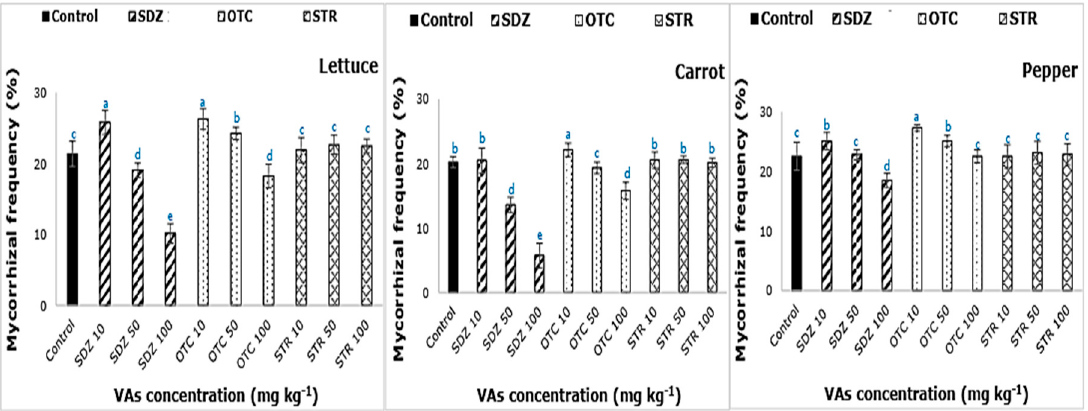
10 of 14 Figure 3. Glutathione-s-transferase (GST) activity of lettuce, carrot and pepper grown in soil treated with VAs. Error bars represent standard error. Concentration values followed by different letters are significantly different ( p < 0.05) according to Duncan’s multiple range test. SDZ = Sulfadimethoxine; OTC = Oxytetracycline; STR = Streptomycin. 3.4. Secondary Experiments In Figure 4, the mycorrhizal frequency (F%) of lettuce, carrot, and pepper plants grown in VAs amended soil is given. Upon comparison with control, F% was affected the most by SDZ, followed by OTC antibiotics. The effect of STR antibiotics on F% of lettuce, carrot, and pepper plants was found not to be significantly different ( p < 0.05) from control. At minimum VAs dosage of 10 mg kg − 1 , the frequency of mycorrhizal colonization was higher than that of control. As described in previous studies, under abiotic stress conditions, increased colonization of plant roots by AM fungi is observed [31–33]. An increase in F% at low concentrations followed a steady decline with the increasing dosage of VAs in the soil-manure mix. The formation of mycorrhizal structures in root is associated with the